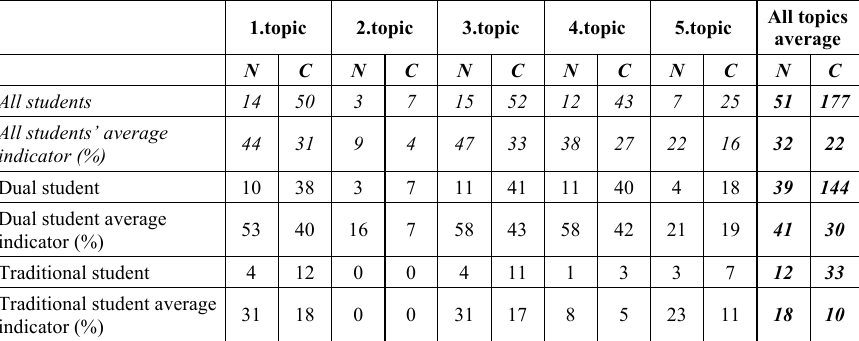
Table 1. Prior knowledge of business topics (N=number of positive answers, C=sum of the confidence values, the indicator values are headcount proportional values) 1.topic